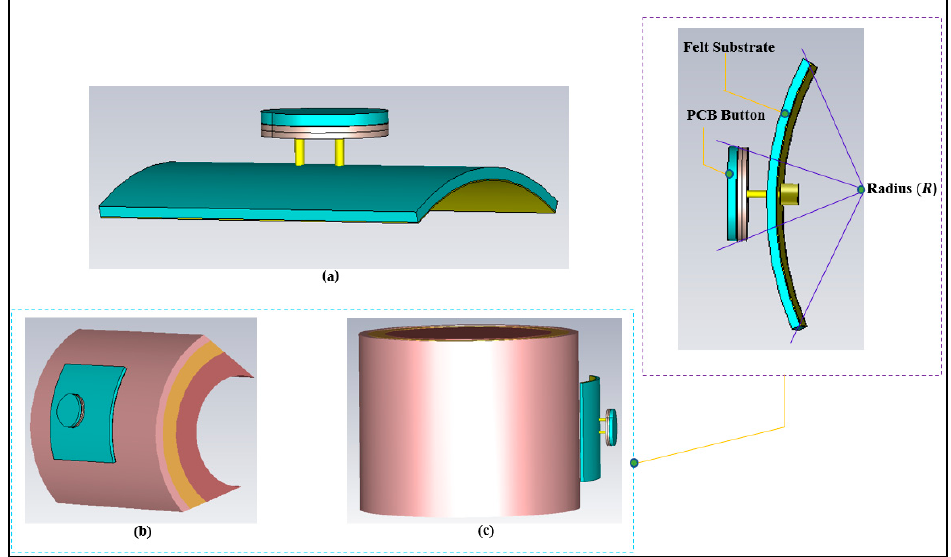
Figure 16. Study cases of the effect of bending of the BSA. ( a ) free space situation, ( b ) flat layered chest phantom (standard size, 200 × 200 × 50 mm (cid:2871) ), and ( c ) arm cylindrical phantom (50 mm ra- dius and 150 mm length).